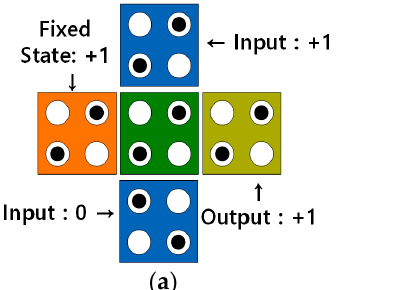
Figure 1. Two polarization states of QCA basic cell: ( a ) P = +1 (binary 1); ( b ) P = − 1 (binary 0).